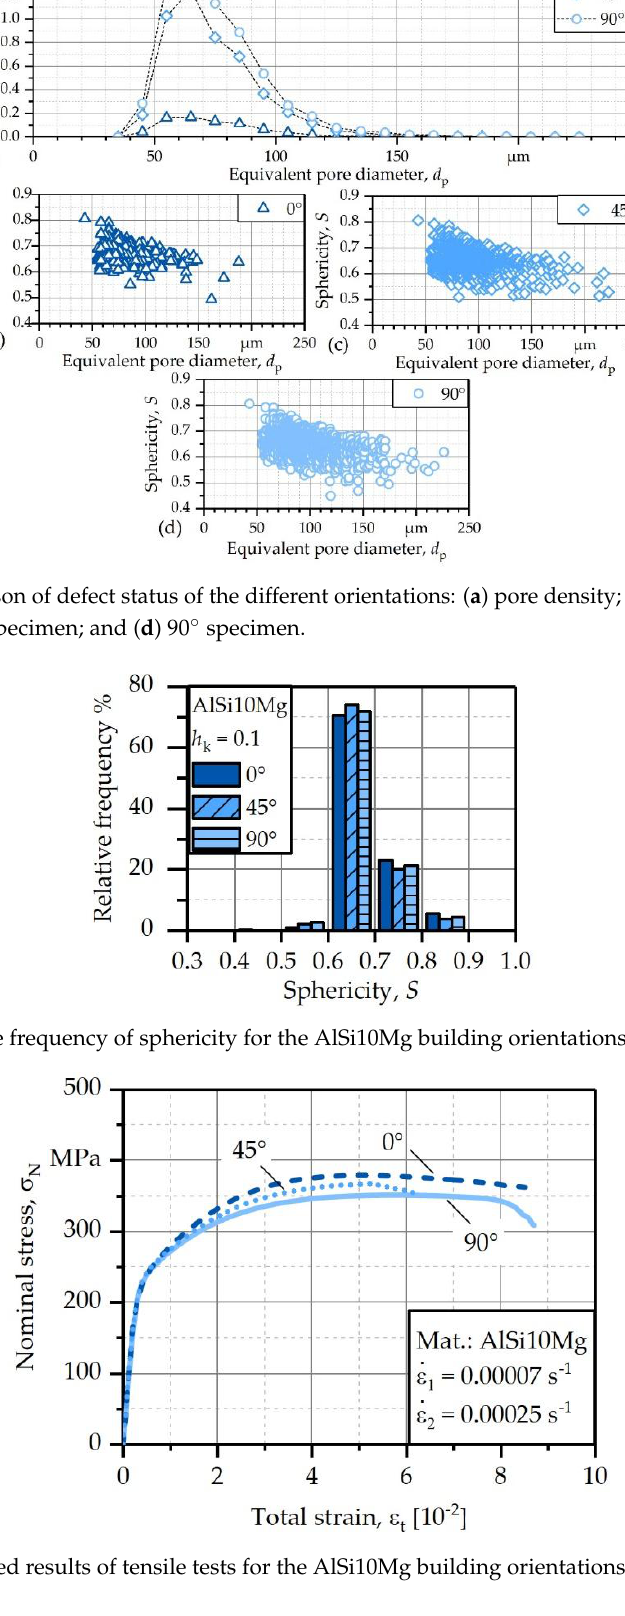
Figure 7. Averaged results of tensile tests for the AlSi10Mg building orientations 0°, 45°, and 90°.